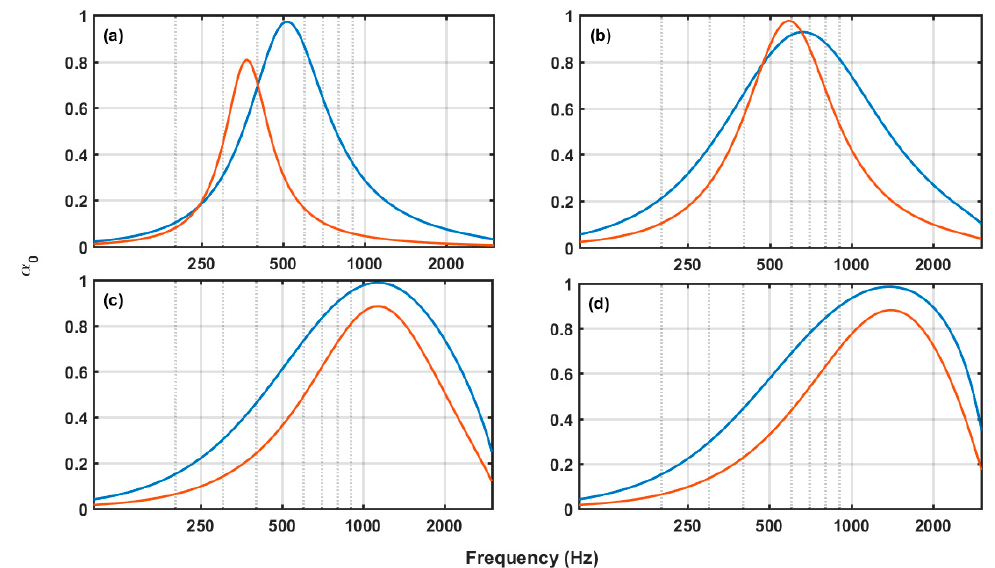
Figure 16. Absorption curves of an SL-MSP (red lines) and the equivalent SL-MPP (blue lines) for D = 5 cm and ( a ) ( d , t , φ ) = (0.5 mm,0.5 mm,0.5%), ( b ) ( d , t , φ ) = (0.25 mm,0.75 mm,1%), ( c ) ( d , t , φ ) = (0.15 mm,1 mm,5%), and ( d ) ( d , t , φ ) = (0.1 mm,1.13 mm,10%).